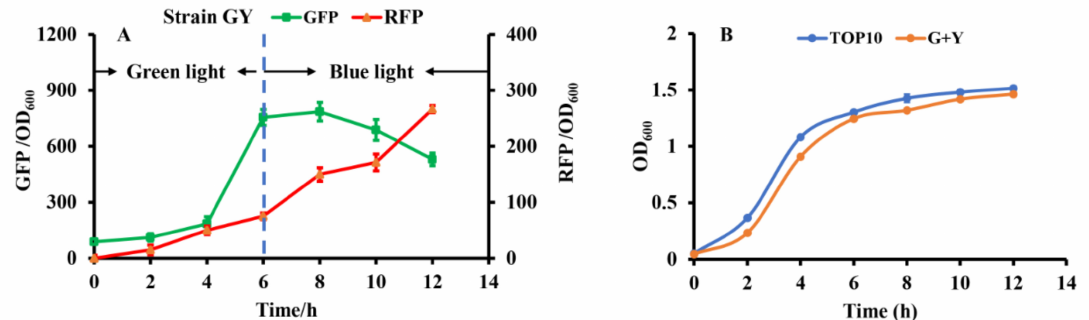
Figure 4. Characterizing the constructed dual-switch system under green and blue light. ( A ) Engi- neered strain GY containing RBS10–CcaS#10–CcaR–sfGFP and YF1–FixJ–PhlF–RFP systems. The system was irradiated with green light for hours 0 to 6 to activate GFP expression, then with blue light for hours 6 to 12 to repress GFP and activate RFP expression. ( B ) Growth of E. coli TOP10 (without light-based system) and GY. All results were calculated with three ( n = 3) independent replications. Error bars represent means ± standard errors of the mean